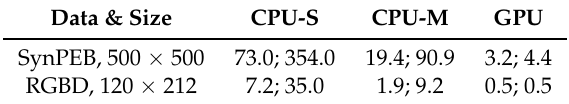
Table 13. Execution timing (ms) for one and five iterations of bilateral filtering.